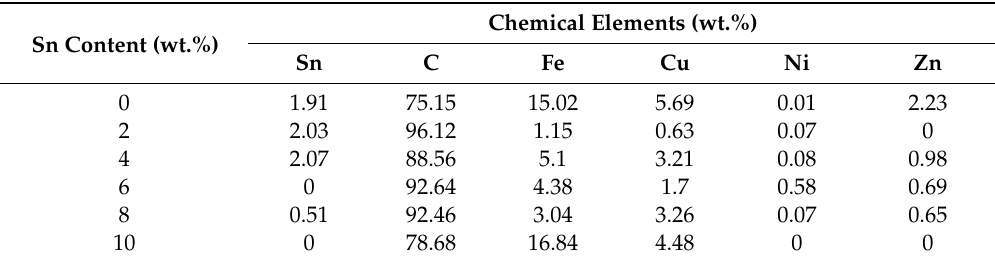
Table 2. EDAX results of interface between the matrix and the diamond under pre-alloyed powders with di ff erent Sn